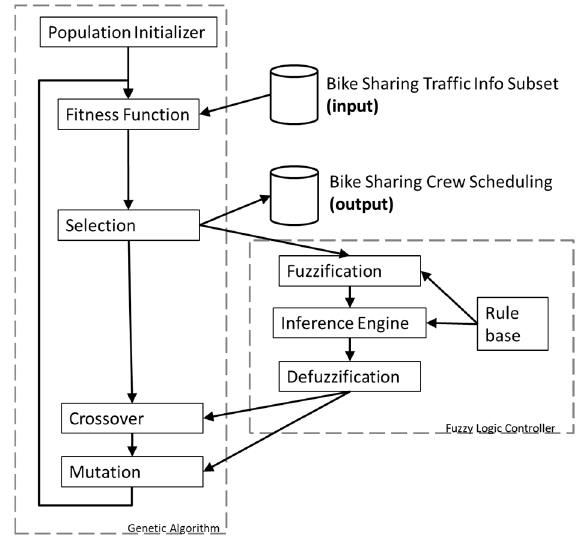
Figure 9. The block diagram of the FLCGA.